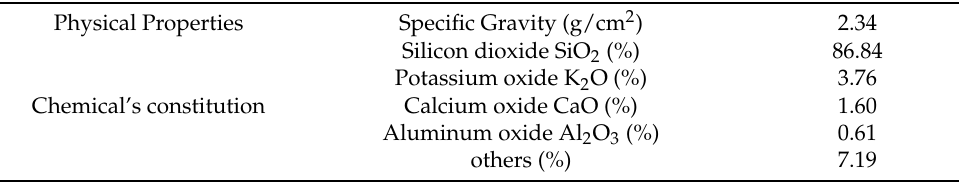
Figure 1. ( a ) Rice husk, and ( b ) rice husk ash. Table 2. Physical characteristics and Chemical’s constitution of rice husk Table 2. Physical characteristics and Chemical’s constitution of rice husk ash.